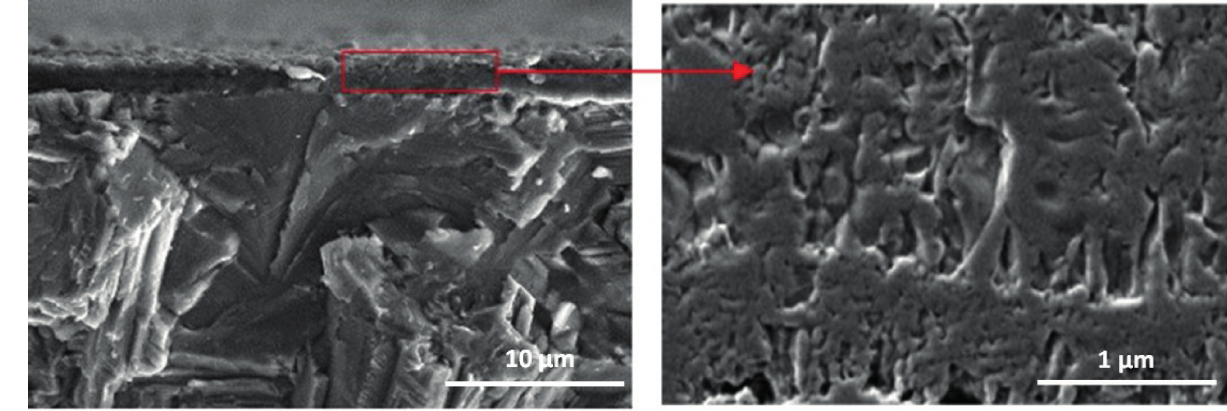
Fig. 2: Cross-section of the sample coated with Al 2 O 3